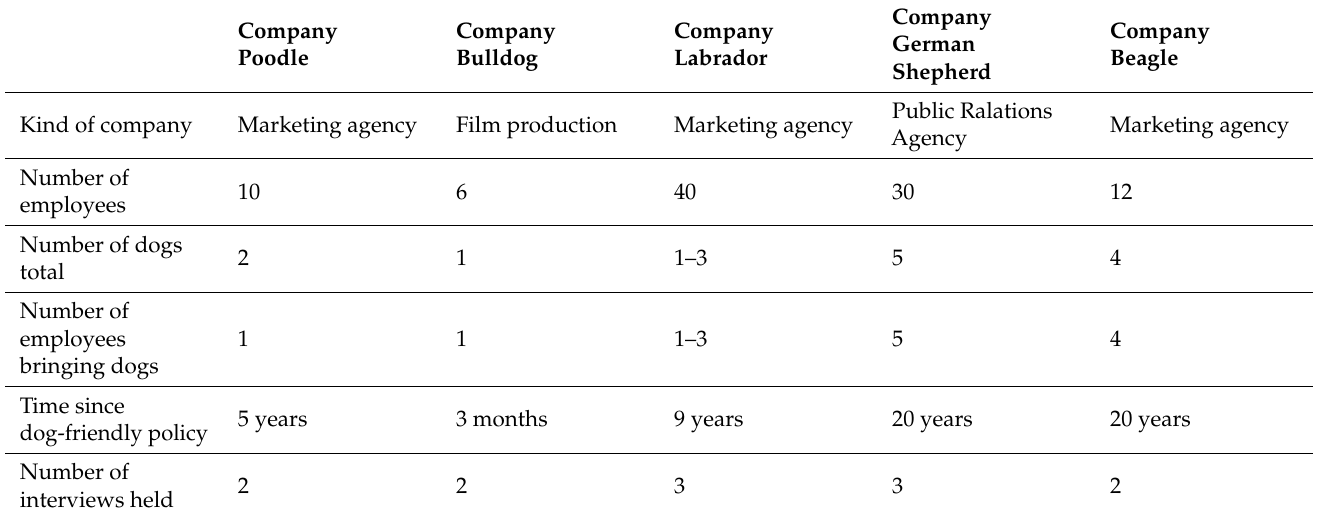
Table 1. Company